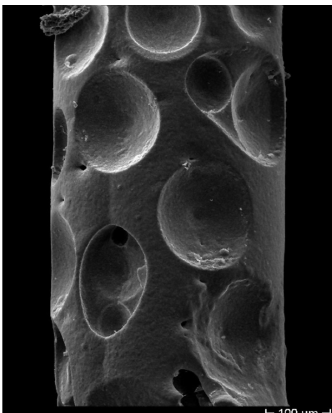
Figure 2. Concave formations on the coating surface as a result of hydrogen bubble presence during Ni electrodeposition